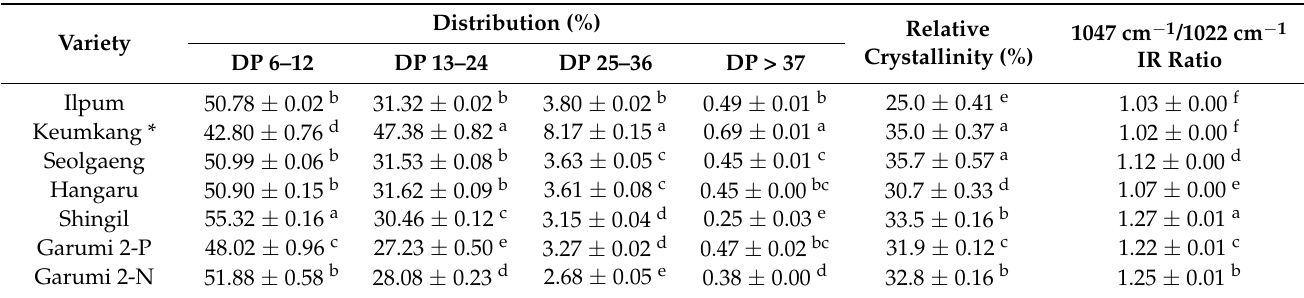
Table 4. Comparison of the chain length distribution of amylopectin, relative crystallinity, and IR parameters of flours obtained from different varieties of rice under study.